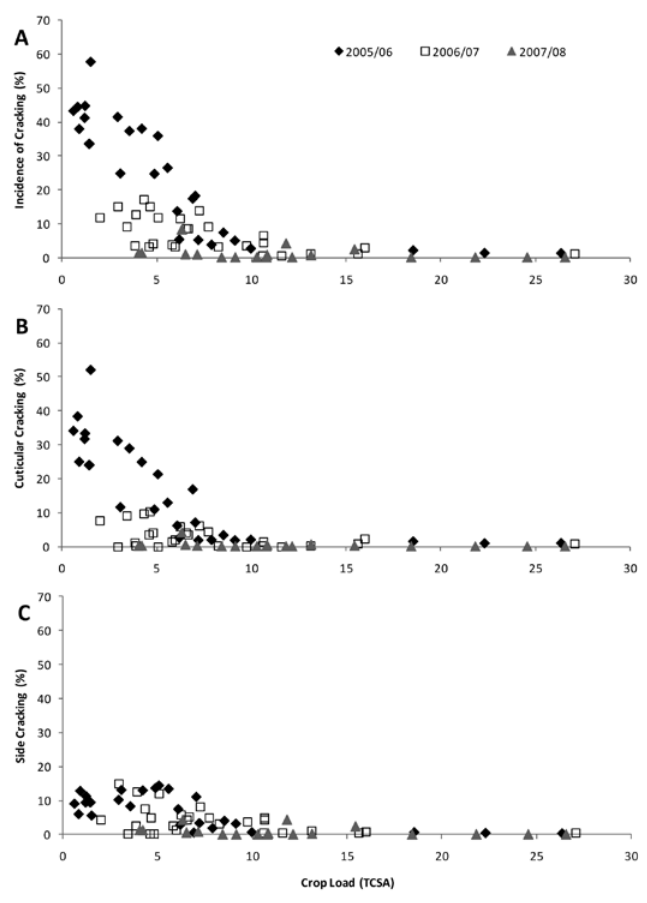
Fig. 5 - The percentage of total cracked fruit (A), cuticular-cracked fruit (B) and side-cracked fruit (C) with natural crop load (TCSA). Each point is for an individual tree. A significant relationship was found between crop load and total cracking incidence in 2005/06 and 2006/07, and between crop load and cuticular cracking in 2005/06, and between crop load and side cracking in 2005/06 and